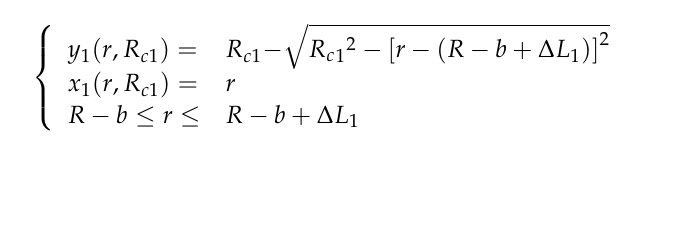
Table 3. Values of alignment errors.